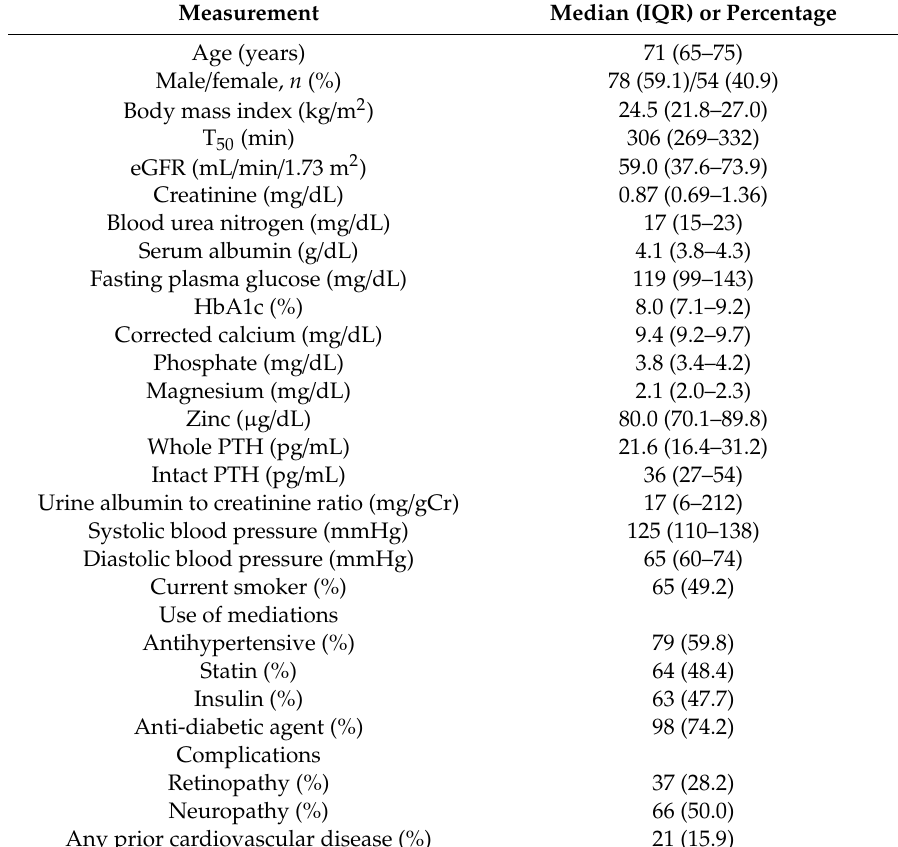
Table 1. Clinical characteristics of the study participants ( n =